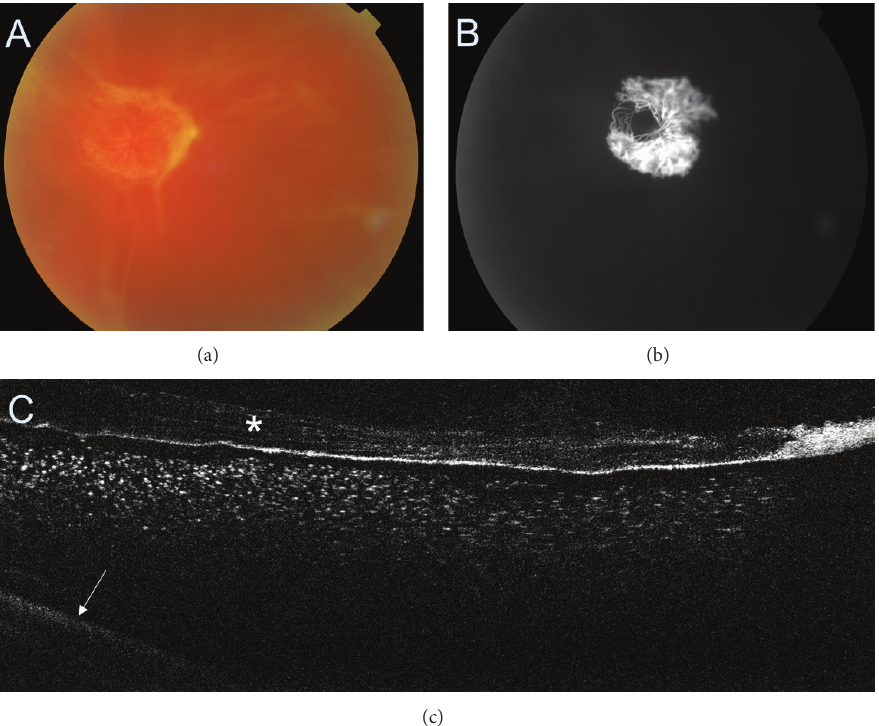
Figure 12: (a) Colour fundus photography of the fibrovascular proliferation. (b) Fluorescein angiography demonstrating the neovascular component of the membrane. (c) SDOCT showing thickened posterior vitreous face (asterisk) with preretinal haemorrhage. The retina is barely visible